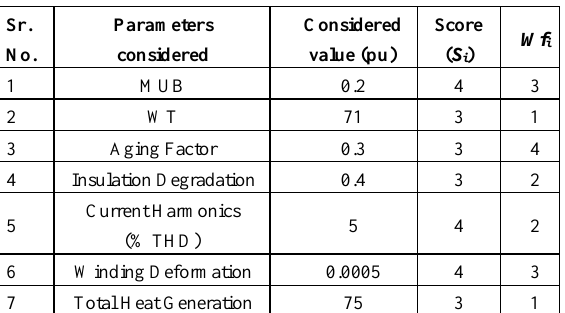
E XAMPLE FOR E STIMATING F ITNESS F UNCTION ( F f